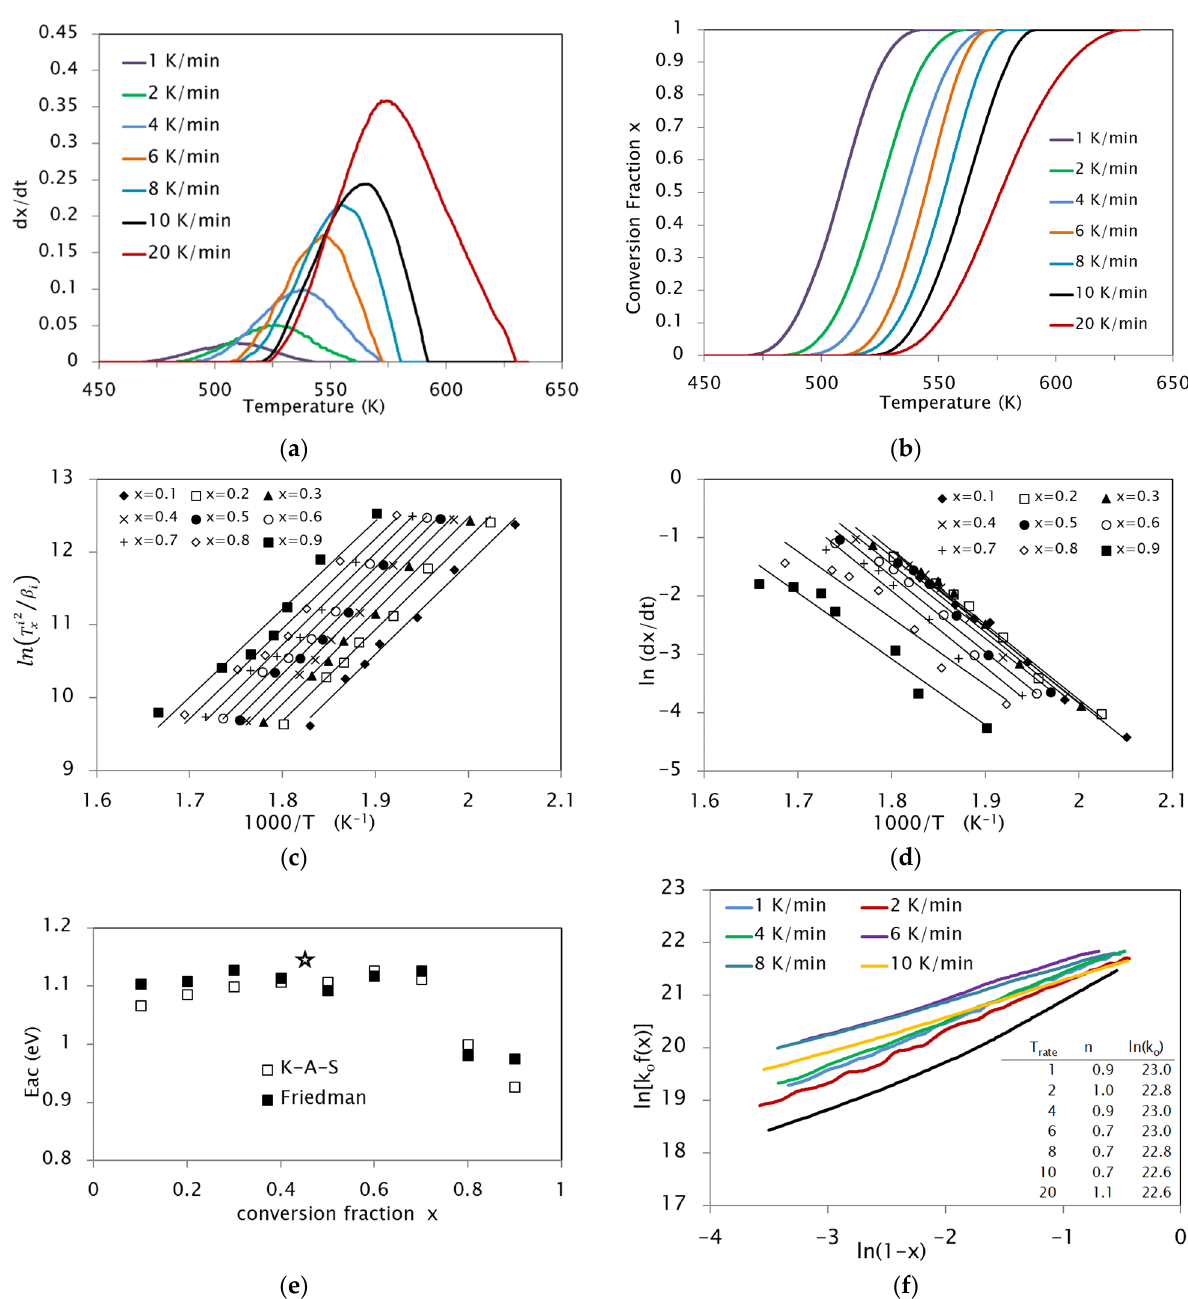
Figure 6. ( a ) (𝑑𝑥 𝑑𝑡⁄ ) curves, corresponding to DSC curves of P 1 after baseline correction, recorded during heating Cu 5 samples quenched from 970 K, at different rates β i = 1–20 K/min; ( b ) normalized integrals giving the x ( T ) curves for the different β i ; application of the Kissinger − Akihara − Sunose method ( c ), and Friedman’s method ( d ); ( e ) apparent activation energies as a function of x obtained after those methods; ( f ) plots of (cid:4670)𝑙𝑛(𝑑𝑥 𝑑𝑡⁄ ) + (𝐸 (cid:3028)(cid:3030) 𝑅𝑇⁄ )(cid:4671) vs.𝑙𝑛(1 − 𝑥) for each β i using E ac = 1.1 eV, yielding the values of n and ln( k o ) given in the inset.